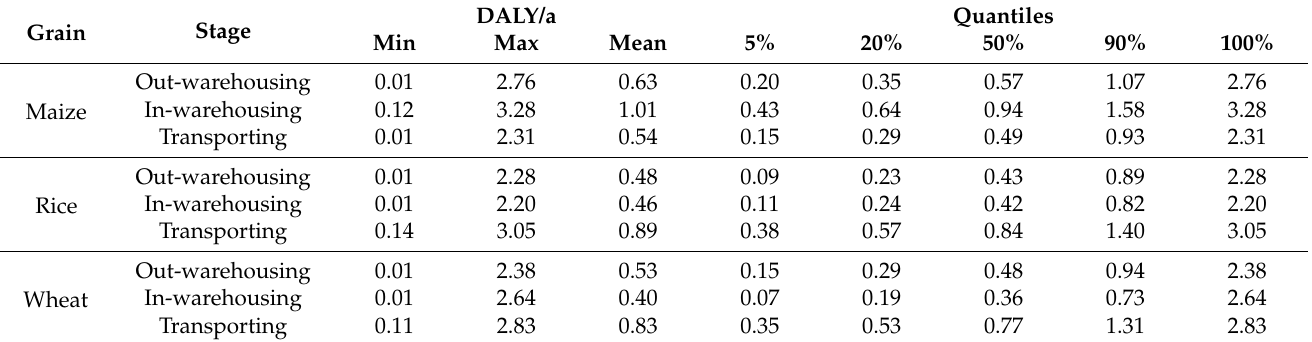
Table 6. Statistical values of the DALY in different stages of each